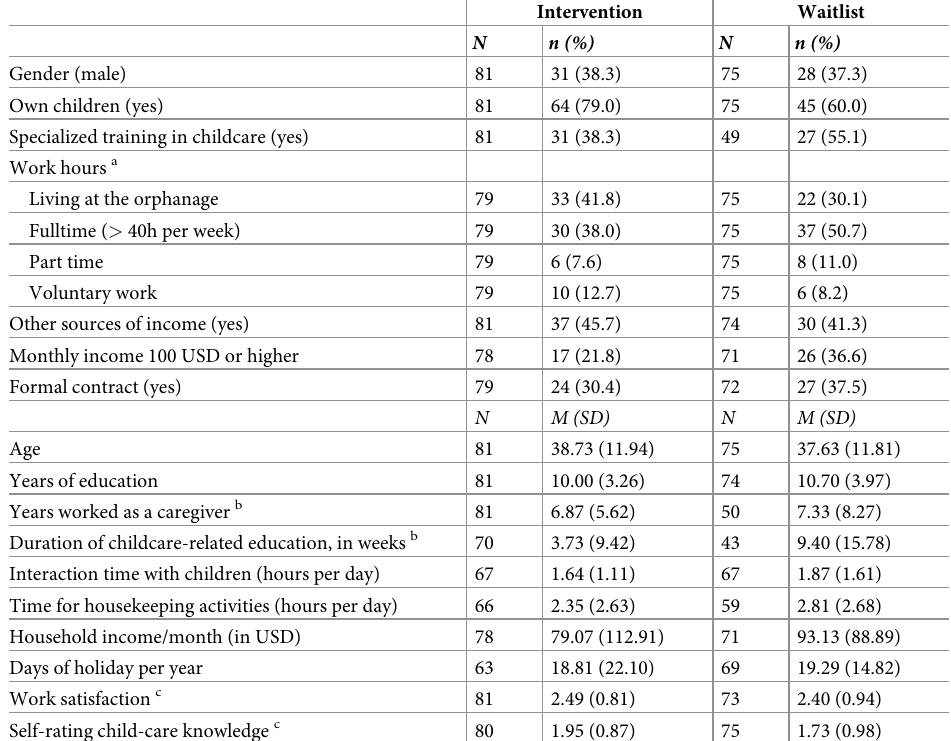
Table 1. Descriptive statistics of demographics of caregivers separated by intervention and waitlist